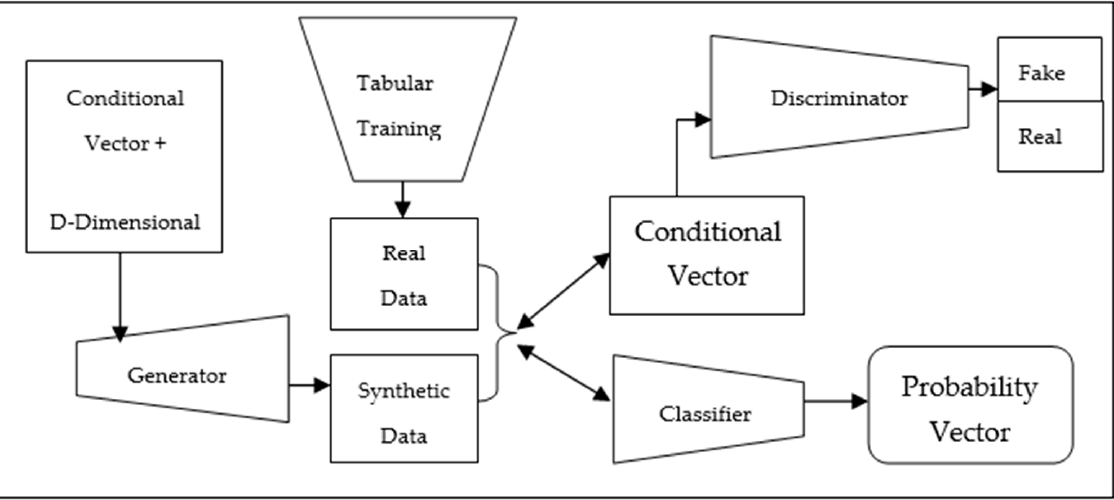
Figure 4. The CTAB-GAN design. Conditional GANs are an expansion of conventional GANs, where both the G and D have to consider additional information. Here we have represented the additional information as c. Here, c can be information of any type.